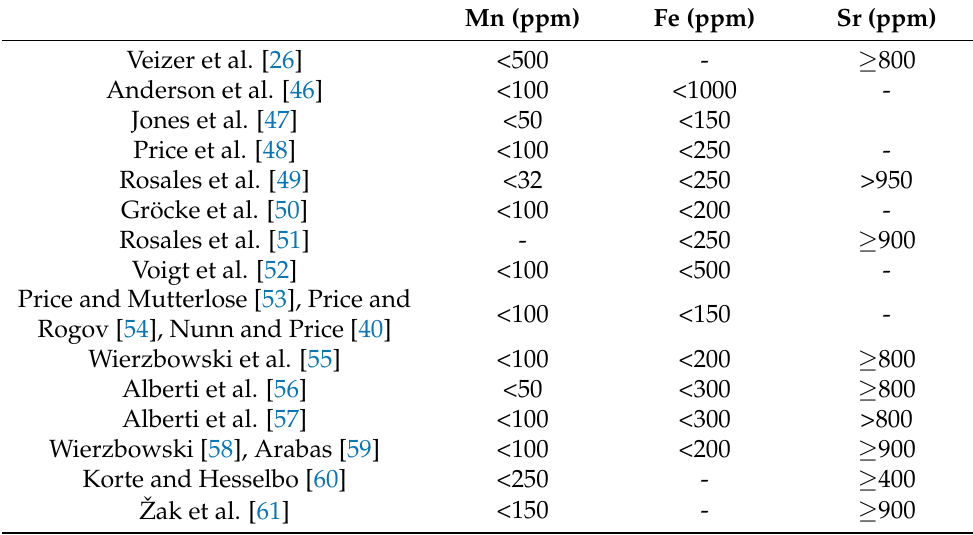
Table 1. Published threshold limits of element concentrations in well-preserved belemnite